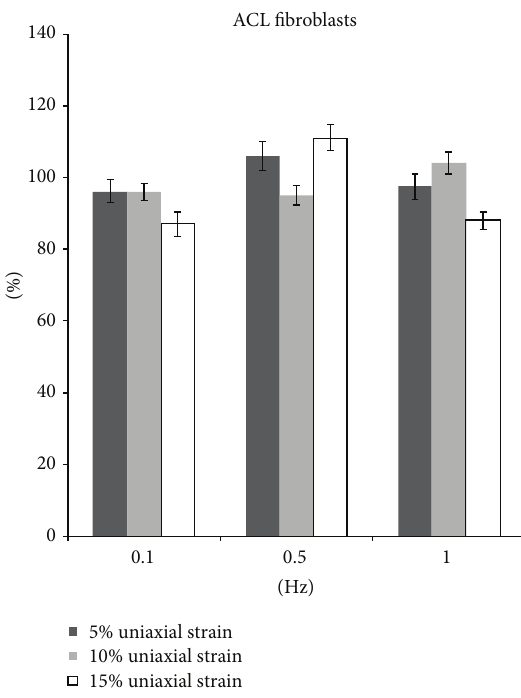
proliferation decreased significantly by 3.9%, 4.1%, and 13.1%, respectively ( 𝑝 <